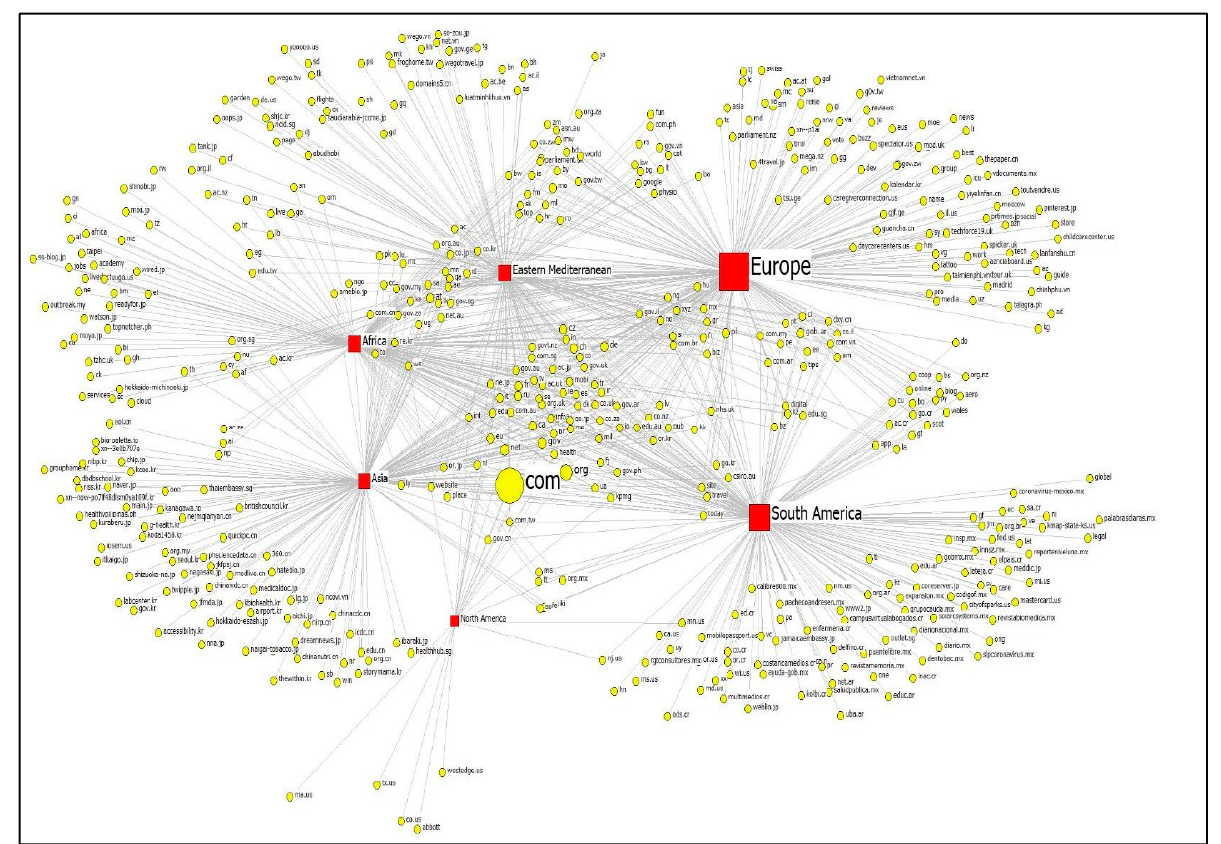
Figure 2. Network of COVID-19 Government Agencies across Regions and TLDs.